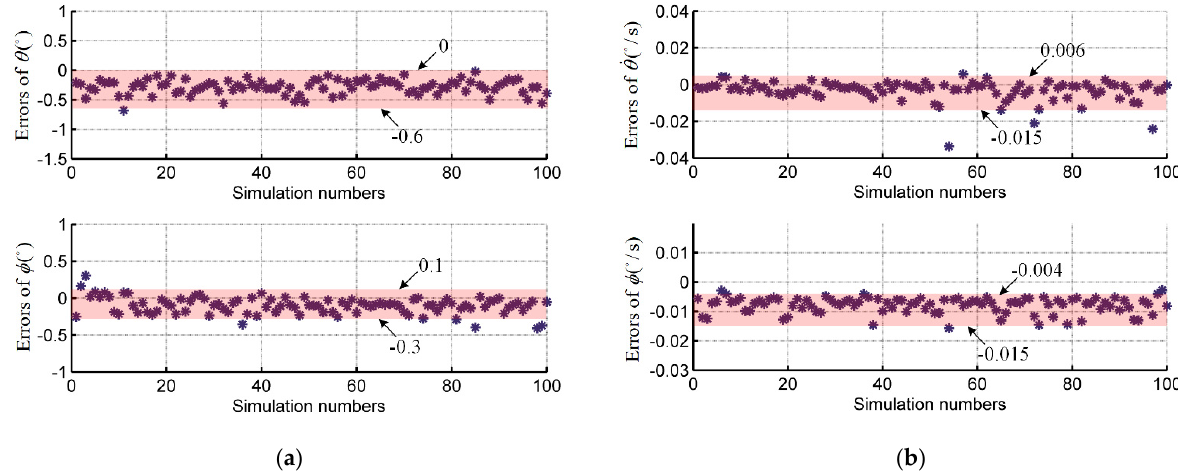
Figure 5. The Monte Carlo simulation result of the errors: ( a ) The LOS angle errors in 100-times simulation; ( b ) The LOS angular rate errors in 100-times simulation.